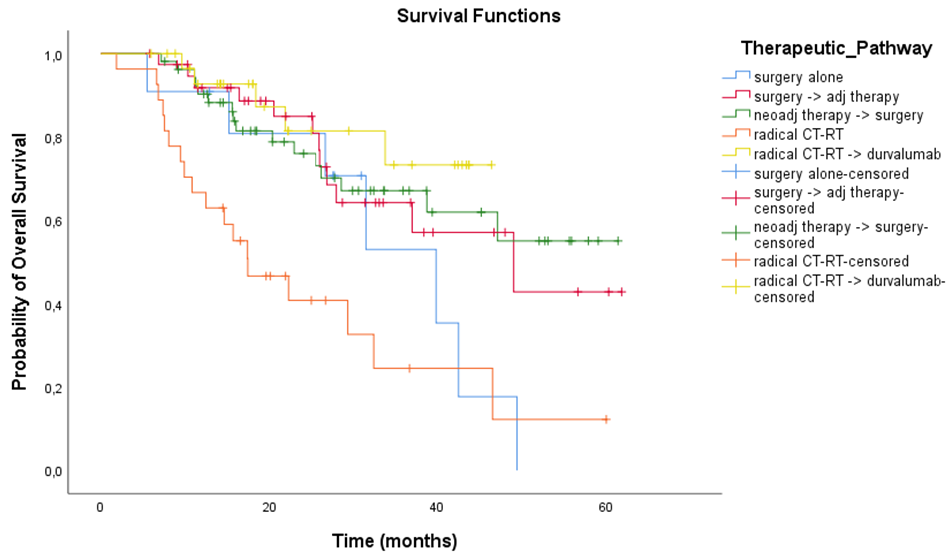
Figure 9. Kaplan–Meier curves of estimated overall survival according to treatment modality in patients treated after 2018. CT-RT, chemo-radiation therapy. Table 5. Survival outcomes as per initial therapy in patients treated after 2018.